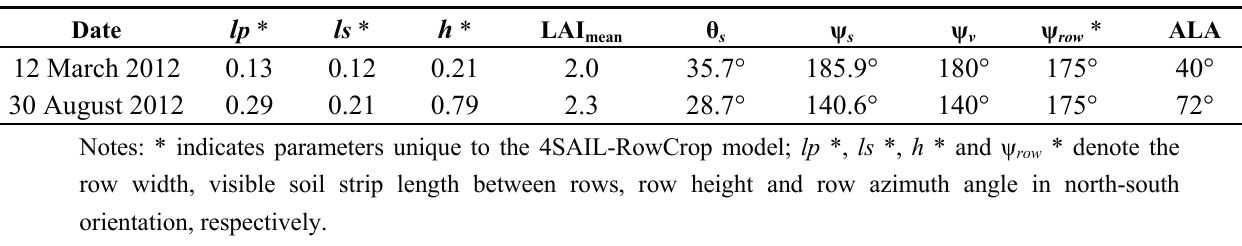
Table 8. Structural, Sun viewing and geometrical parameters used in the 4SAIL- RowCrop model.